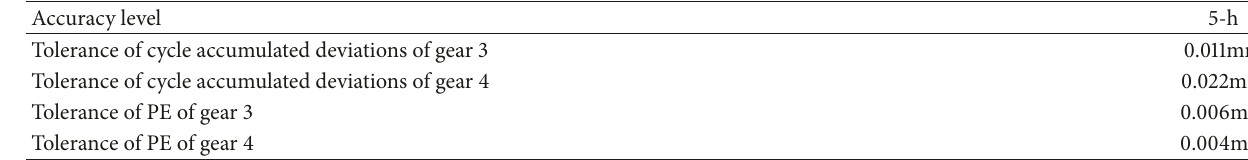
Table 2: Optimized gear